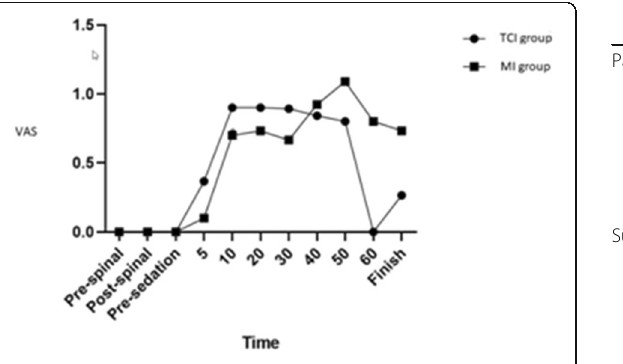
Fig. 7 Changes in visual analog scale. Values are mean ± SD